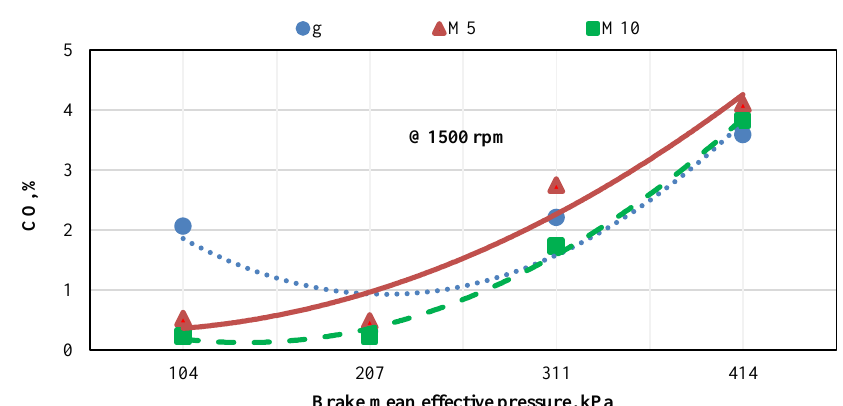
Fig. 6. CO emission for tested fuels at different loads.